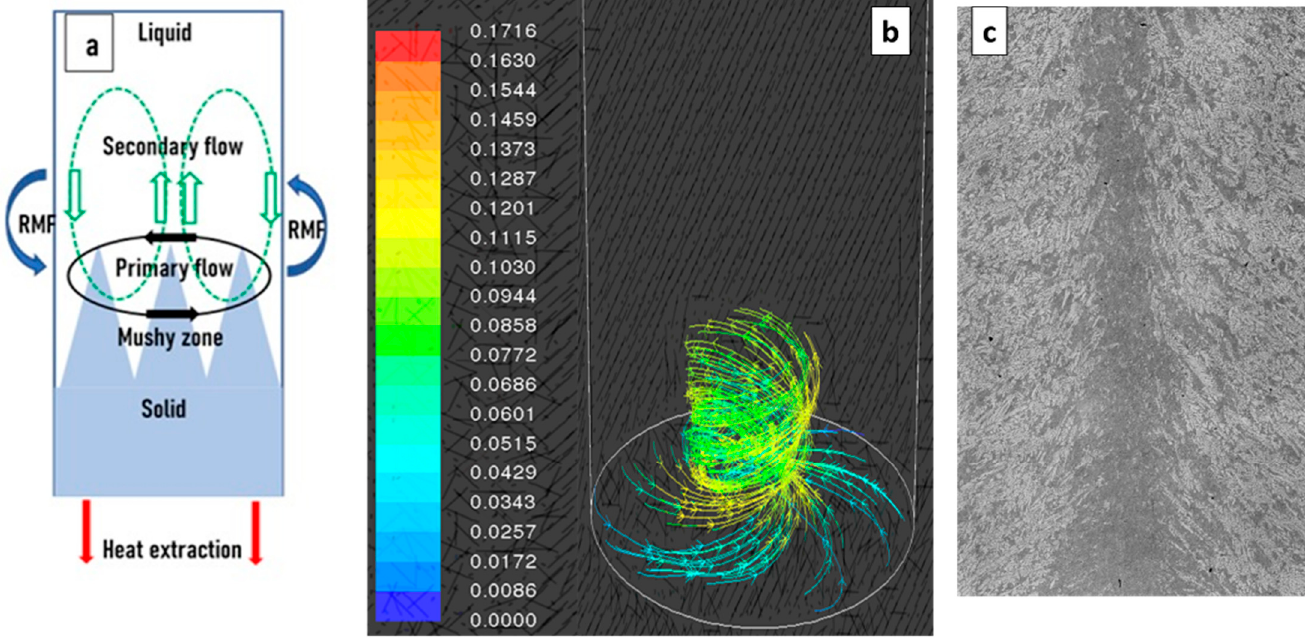
Figure 1. ( a ) The primary and secondary melt flow in the unidirectionally solidified sample. ( b ) simulated spiral flow in the pure liquid phase, the flow paths colored by the velocity magnitude (m/s). ( c ) “Christmas Tree Like” (CTL) macrostructure.